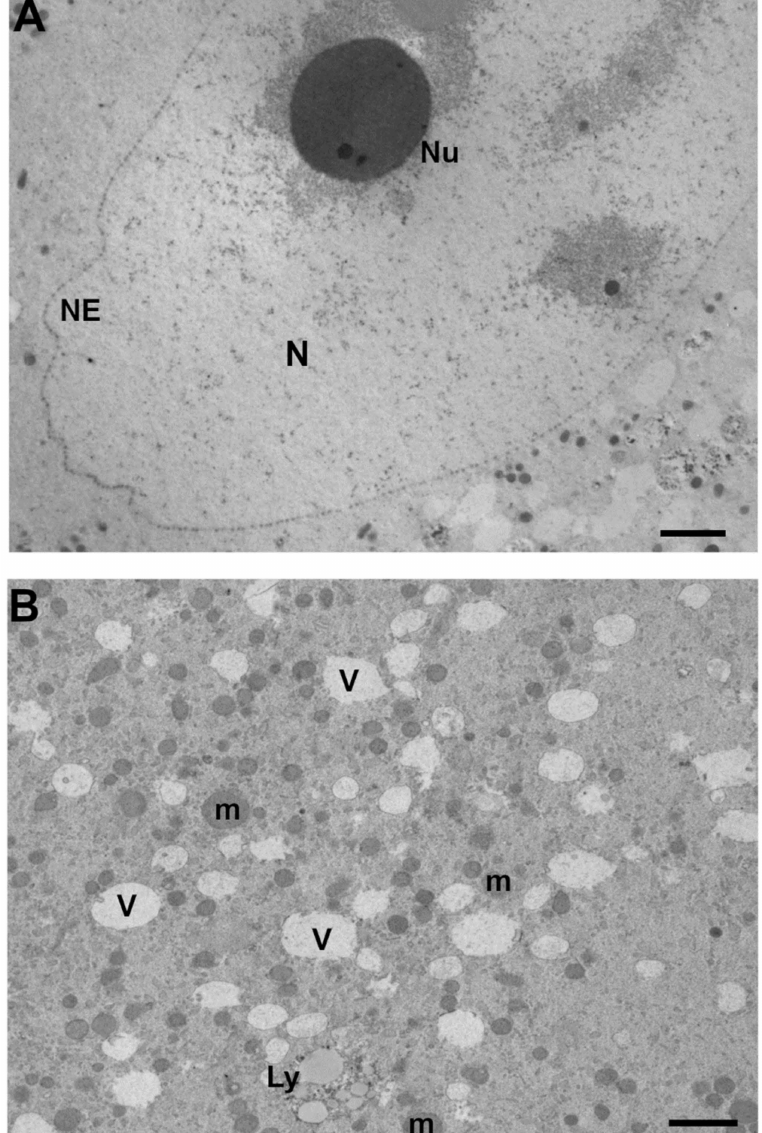
Figure 1. Representative unpublished archived TEM micrographs of GV-stage human oocytes from stimulated ovaries [22,29,30] showing in ( A ) the nucleus (N) delimited by a continuous nuclear envelope (NE) made by a double layer interrupted by electron pale nuclear pores. The nucleoplasm is characterized by a round and electron-dense nucleolus (Nu), dark fibrous clusters of heterochromatin and dispersed euchromatin. TEM, bar: 1 µ m; ( B ) the ooplasm rich in electron-lucent vacuoles and small vesicles, delimited by a continuous membrane and sometimes presenting visible inclusions or debris. Numerous round-to-ovoid mitochondria (m) with slightly electron-dense cristae and big secondary lysosome (Ly) with numerous vesicles of different electron-density. TEM, bar: 1 µ